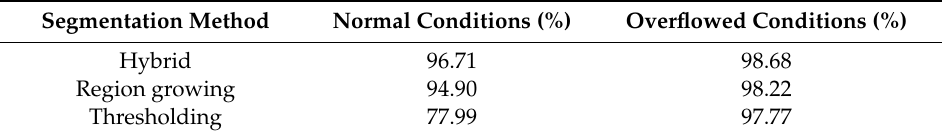
Table 1. Dice score (DSC) for normal and overflowed conditions.